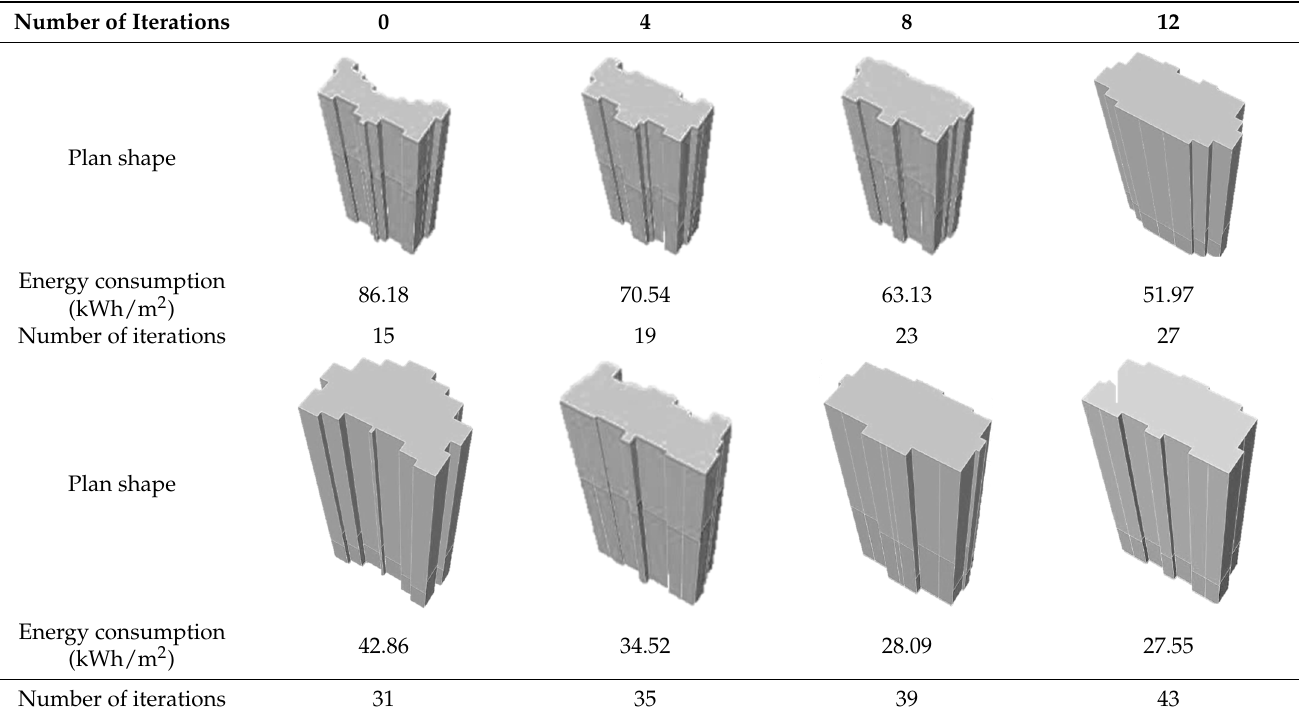
Table A2. Tianjin area floor plan generation process results.